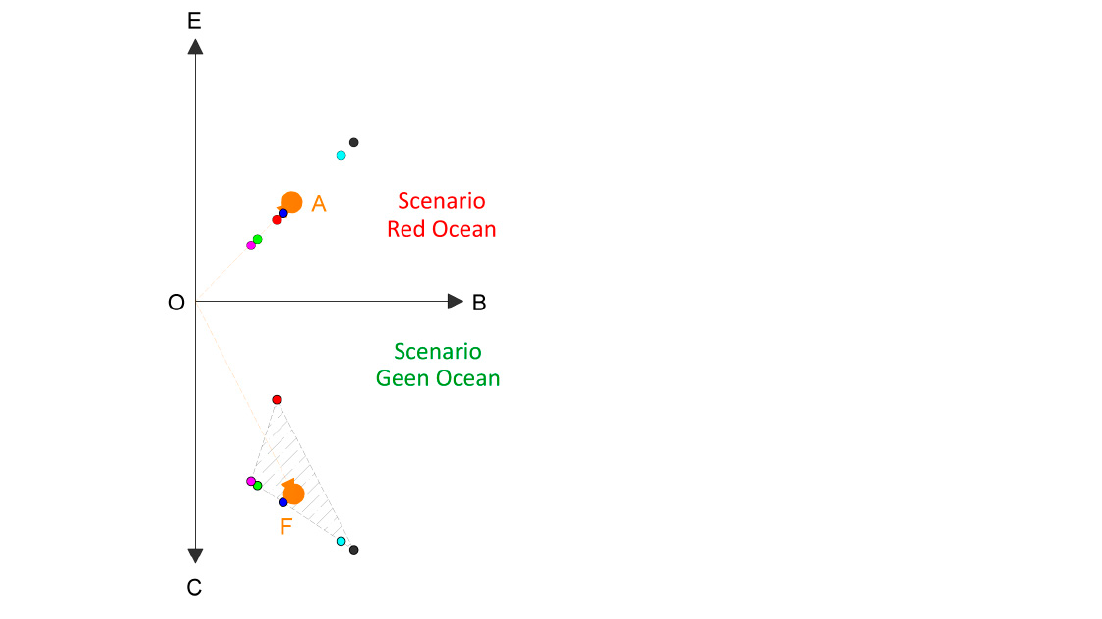
Figure 7. Visualization of development paths: vector OA and vector OF. Source: own calculation. The designations O, E, A, B, F and C are as shown in Figure 3.